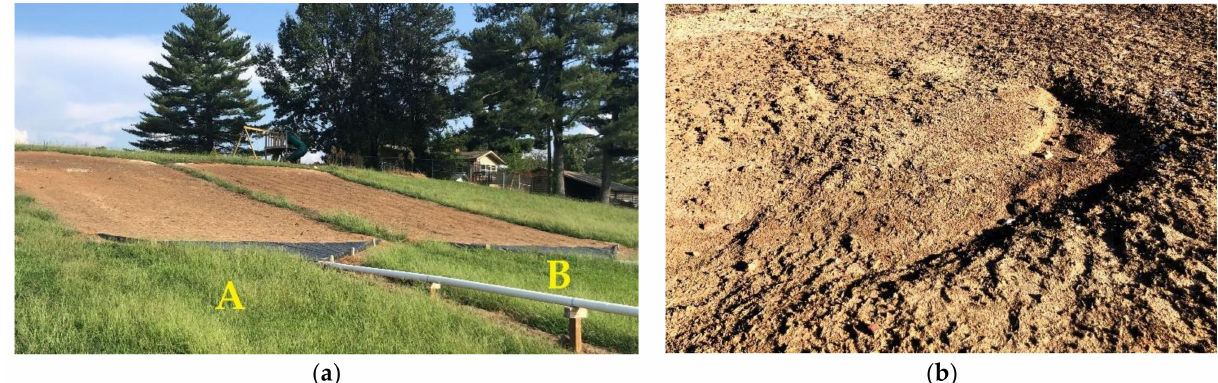
Figure 3. ( a ) Photograph of study site from the bottom of the slope. Plots A and B are indicated. ( b ) Close photo of Plot A soil